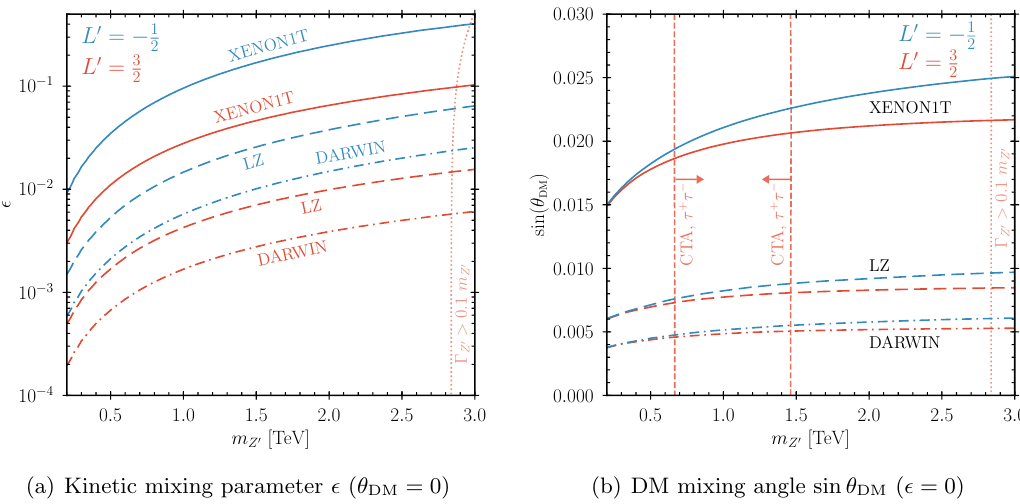
(a) Kinetic mixing parameter (cid:15) ( (cid:18) DM = 0) (b) DM mixing angle sin (cid:18) DM ( (cid:15) = 0) Figure 5 . Direct detection limits on the Z Z 0 and (cid:23) DM (cid:23) 4 mixing for L 0 = 1 = 2 (blue) (cid:0) (cid:0) (cid:0) and L 0 = 3 = 2 (red). Current constraints from the XENON1T experiment [44] are shown as solid lines, the long-dashed lines indicate the projected sensitivity of LZ [45], and the dash-dotted lines correspond to DARWIN [46]. The DM mass is (cid:12)xed by the requirement to reproduce the Planck relic density, all other parameters are set according to table 2. The short-dashed lines in 5(b) indicate the prospective reach of the CTA [47] indirect detection experiment. The light, dotted lines show the region where the Z 0 width grows above 10 % of the